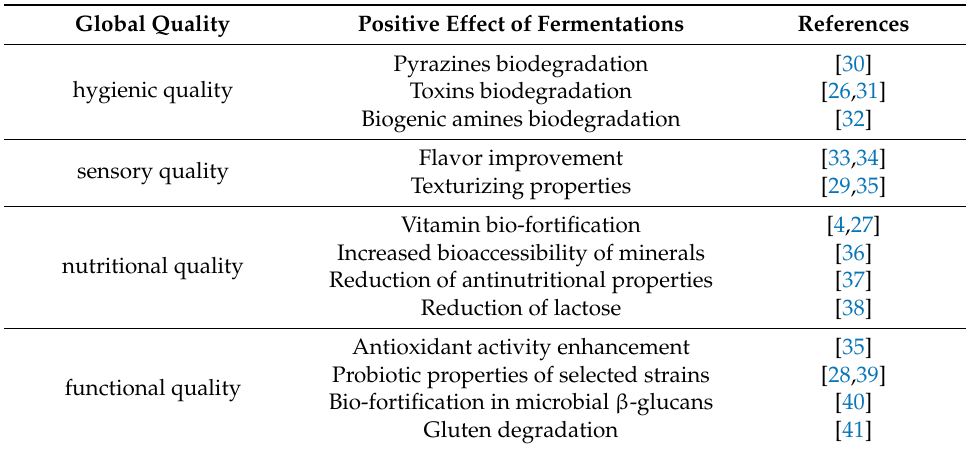
Table 2. Some examples about the impact of microorganisms associated with fermentations on the main aspect of global quality of fermented